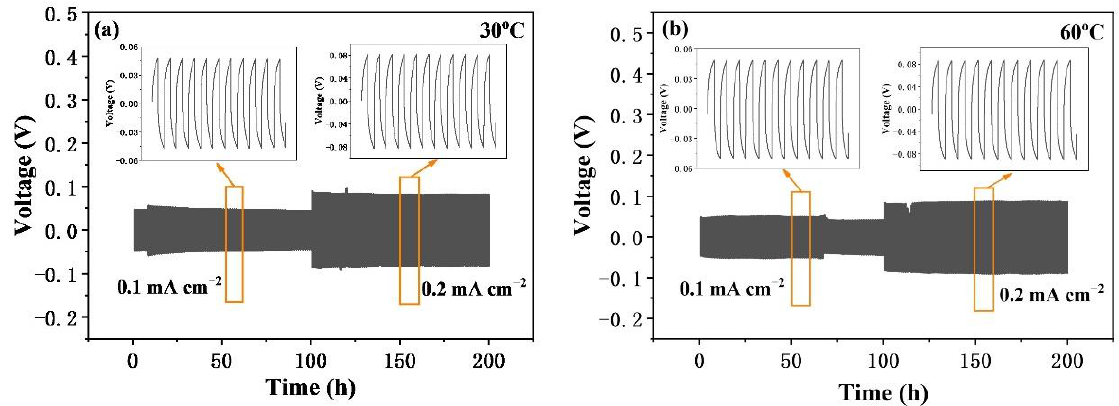
Figure 6. Constant current charge and discharge cycling of Li/CSE/Li symmetric batteries at ( a ) 30 °C and ( b ) 60 °C.